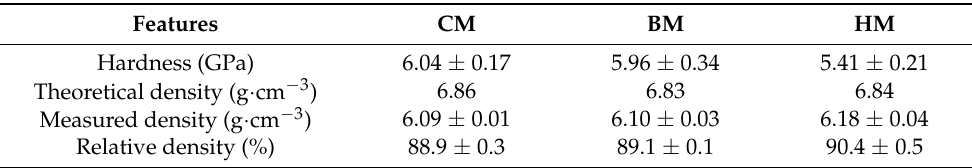
Table 4. Characteristics of the NiO-GDC discs obtained under the different processing methods (BM, CM, and